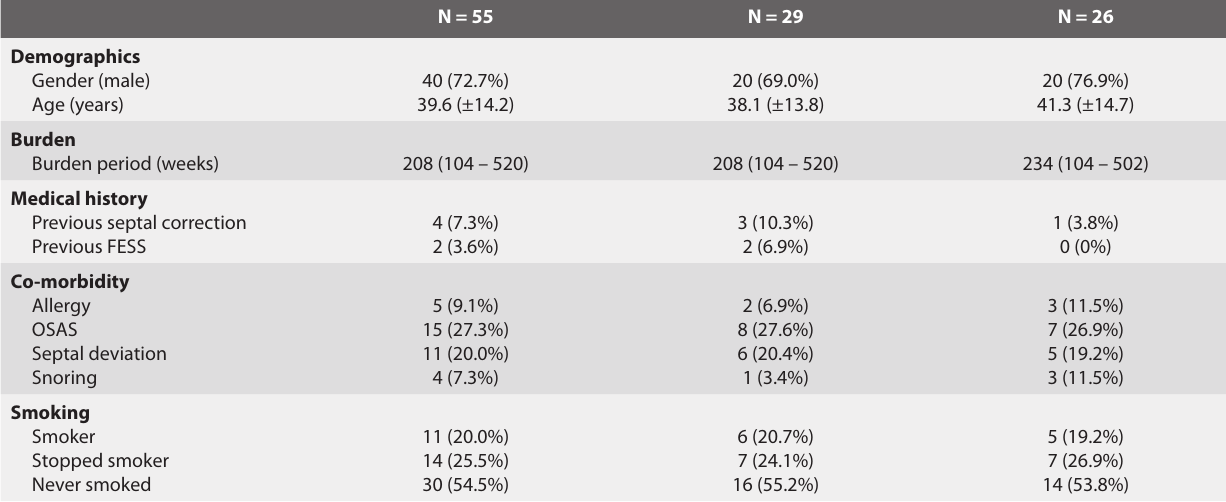
Table 2. Subject demographics and